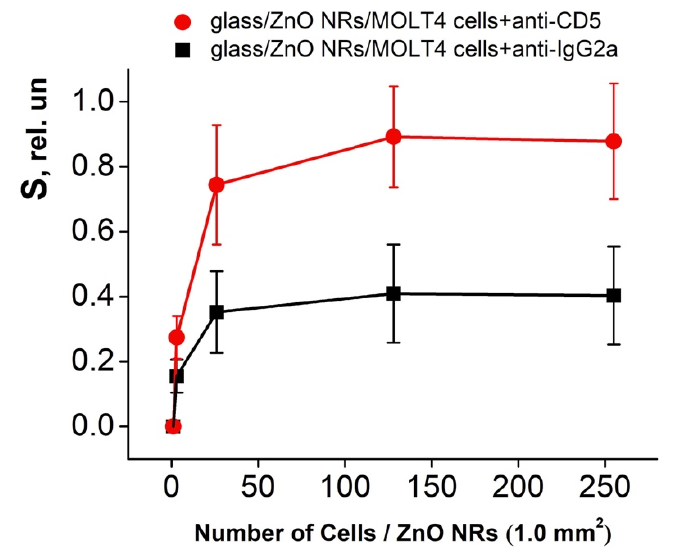
Figure 5. RT PL spectra of ZnO NRs platform after immobilization of the di ff erent number of MOLT-4 cells conjugated with anti-CD5 ( A ) and anti-IgG2a ( B ) monoclonal antibodies.